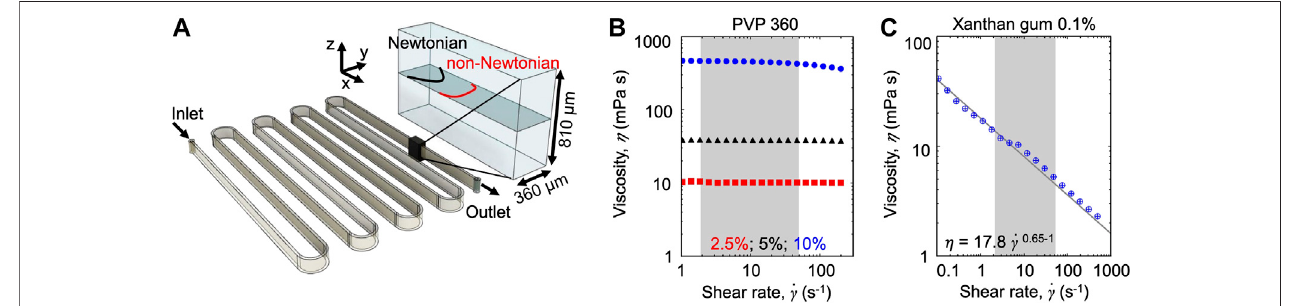
FIGURE 1 | (A) Schematic of the serpentine microchannel used for the experiments (left) and perspective view (right) showing the imaging plane (gray), the parabolic Newtonian fl ow pro fi le (black), and a representative non-Newtonian pro fi le (red). (B,C) Viscosity as a function of the shear rate for the Newtonian PVP 360 solutions at 2.5 w/v% (red), 5 w/v% (black), and 10 w/v% (blue) (B) and for the 0.1 w/v% xanthan gum solution (C) . The shaded areas highlight the shear rate _ γ range explored in the current study. The grey line in (C) represents the power-law fi t which describes the non-Newtonian constitutive relation (blue